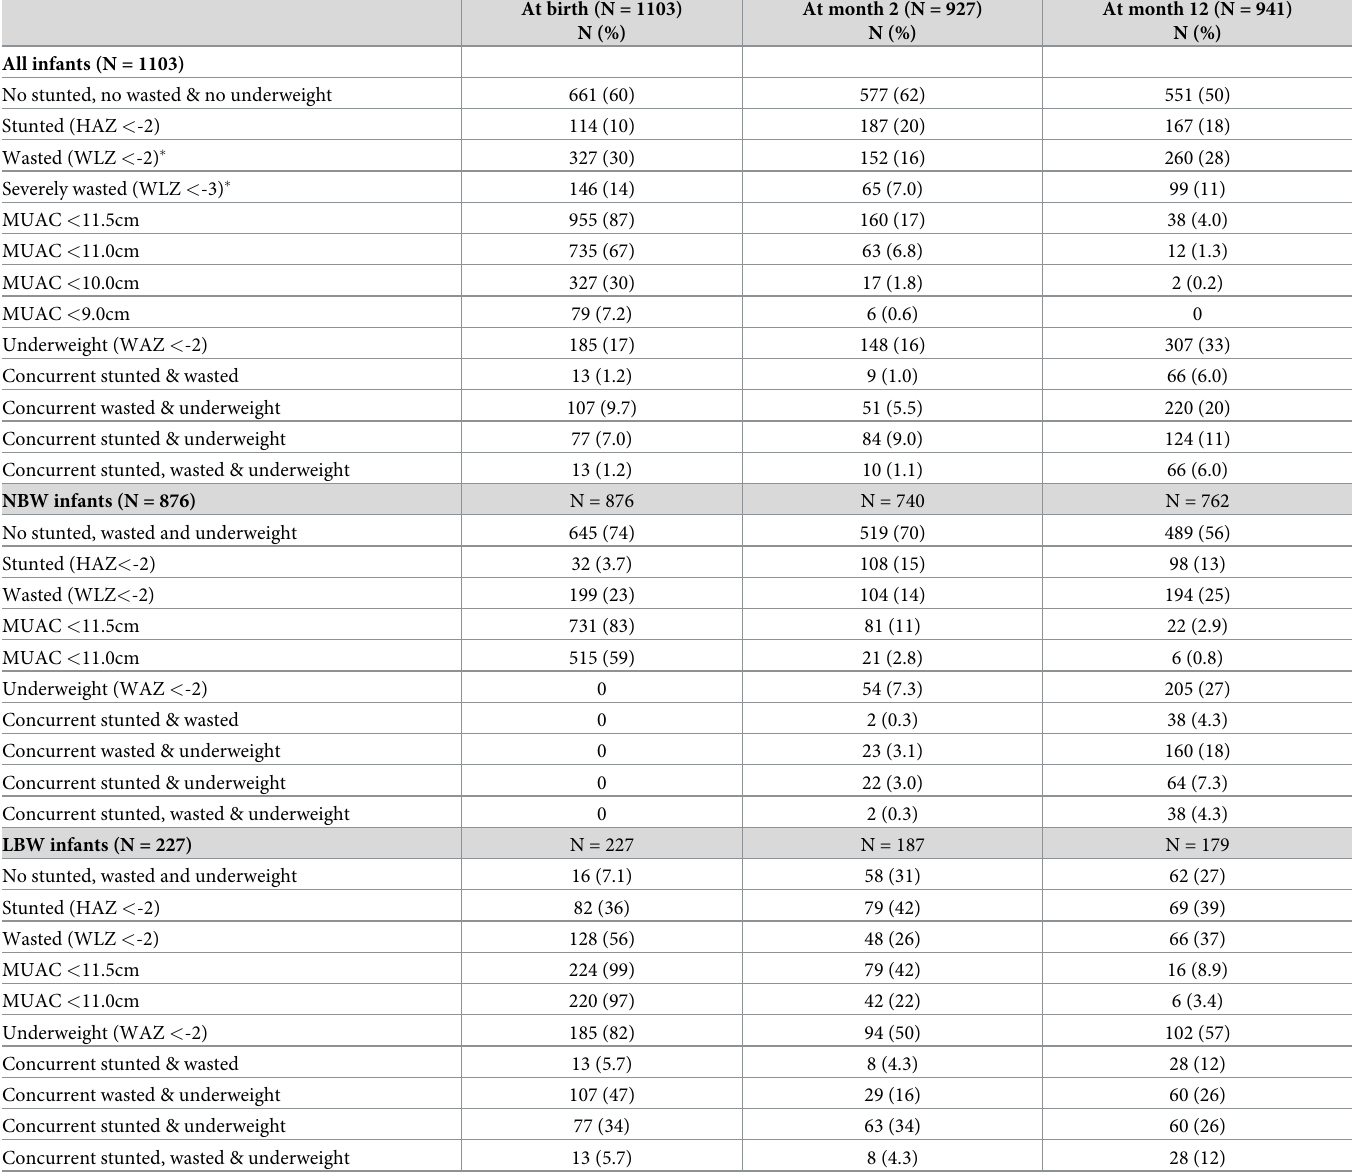
Table 1. Anthropometric categories at birth, two and twelve months of